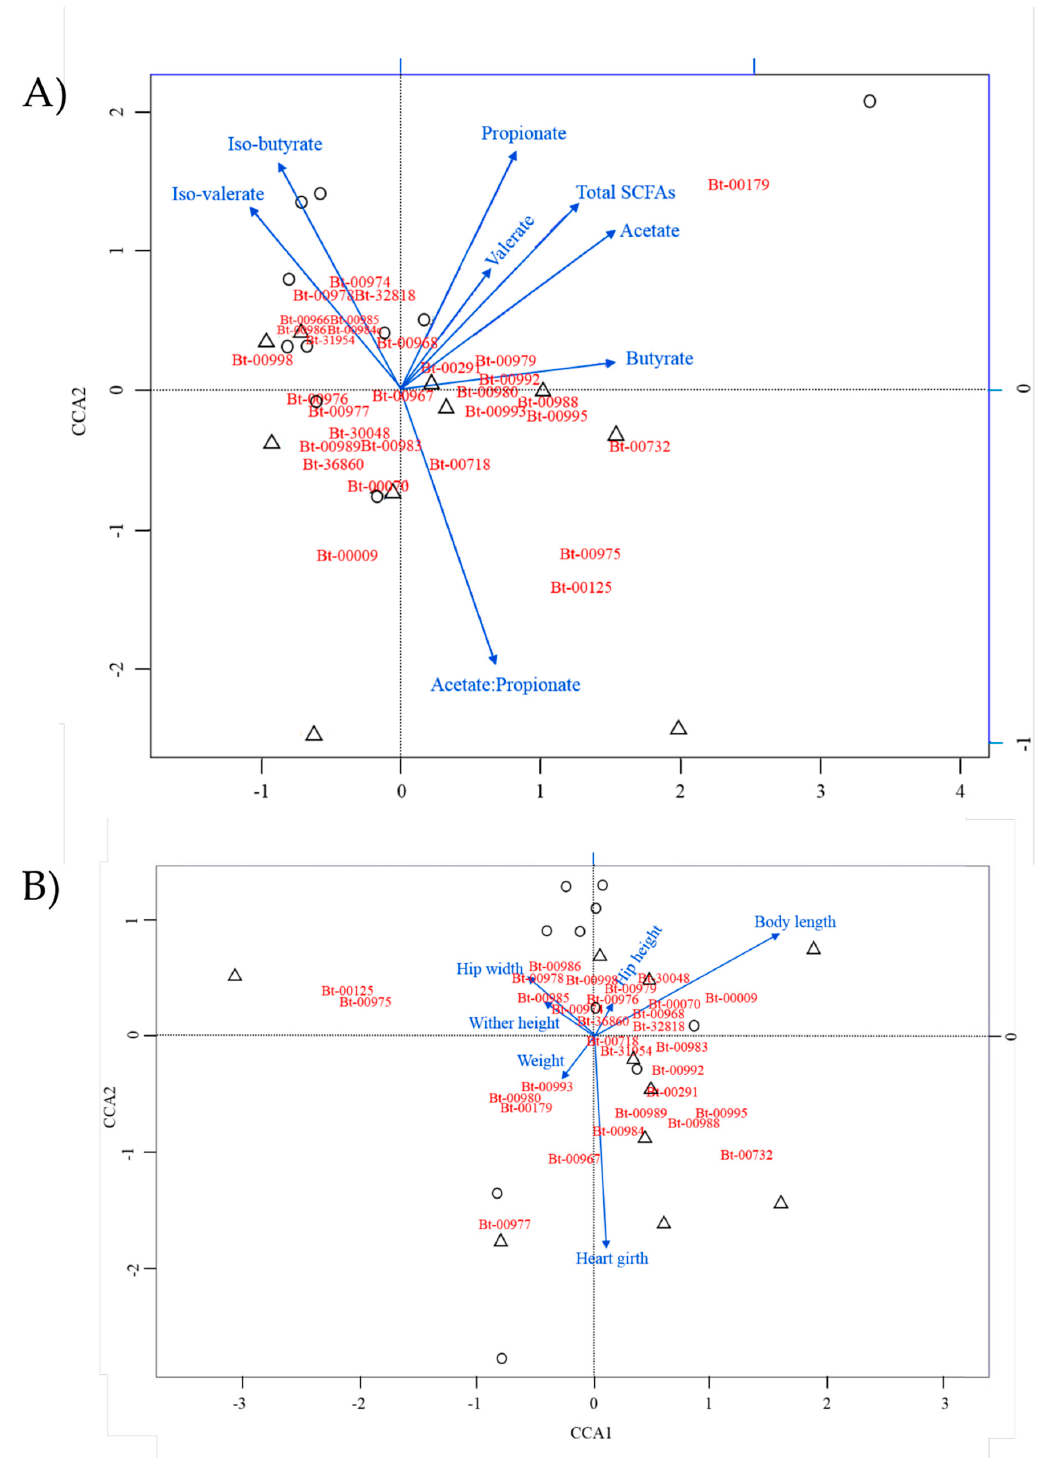
Figure 4. Canonical correspondence analysis (CCA) to uncover associations between main OTUs and short chain fatty acid (SCFA) parameters ( A ) or dairy calf performance attributes ( B ) as explanatory variables. The length of an arrow represents the relative influence of its corresponding explanatory variable on the distribution of the OTUs analyzed. EO and control samples are represented by circles and triangles, respectively.